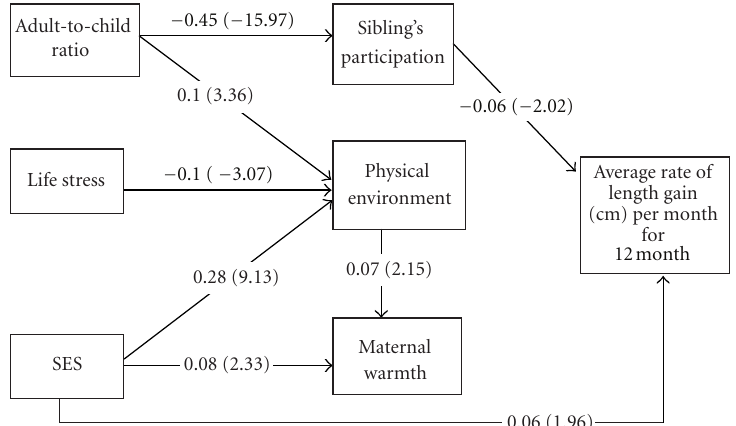
Figure 2: Standardized path coe ffi cients ( t -values) for a path model between SES and infant length gain, mediated by home environment in 1-year-old Chilean infants (CFI = 0.98, SRMR = 0.02, RMSEA = 0.03). All paths are statistically significant ( P < 0 . 05). SES significantly correlated with adult-to-child ratio and life